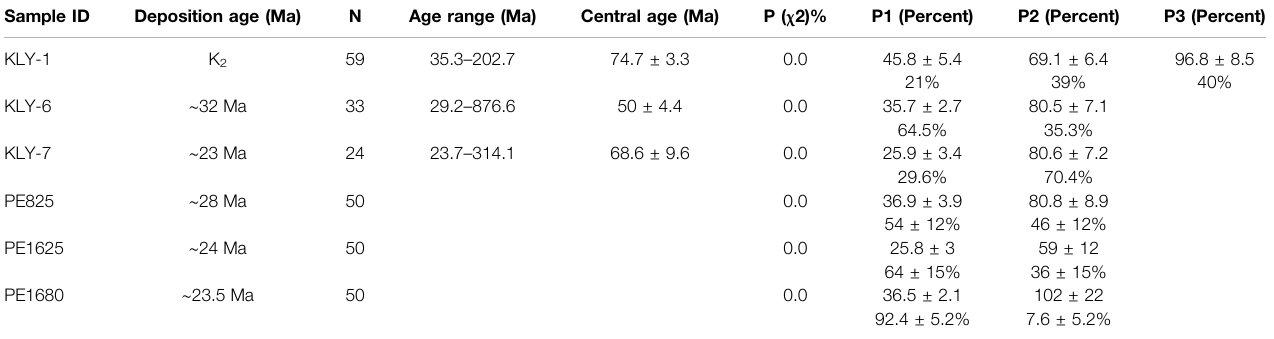
TABLE 2 | Detrital apatite fi ssion track results of the Keliyang section in the SW Tarim Basin. Sample